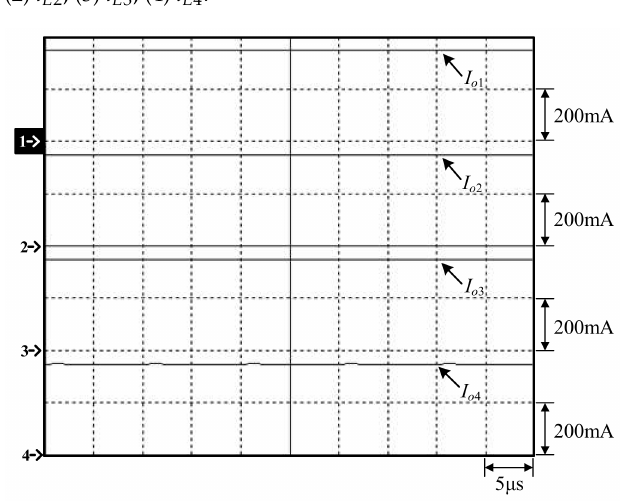
Figure 32. Simulated waveforms relevant to different numbers of LEDs for LED strings: (1) i L 1 ; (2) i L 2 ; (3) i L 3 ; (4) i L 4 .